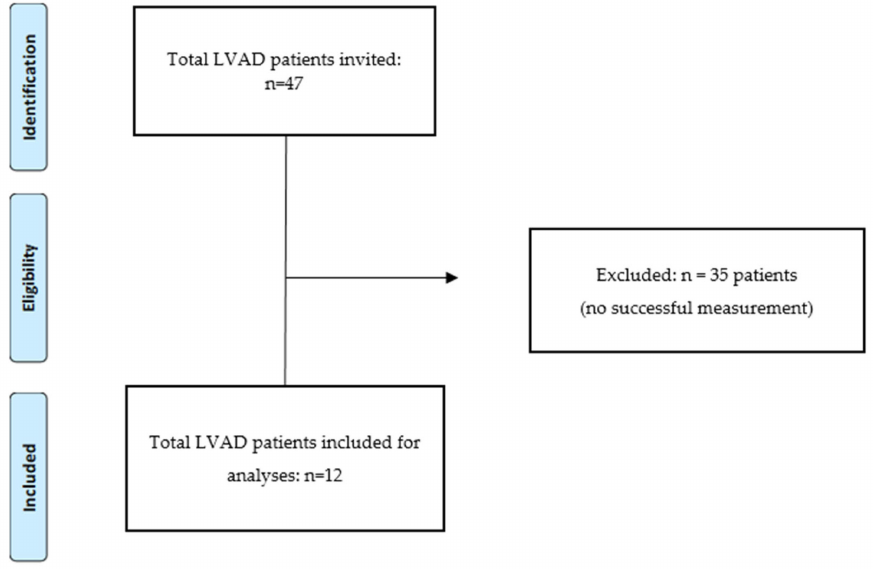
Figure 1. Flowchart inclusion of